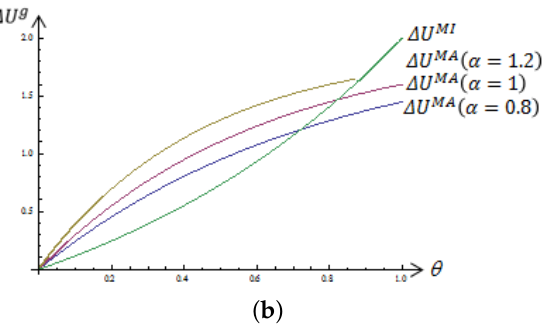
Figure 1. General Area under Different Parameter